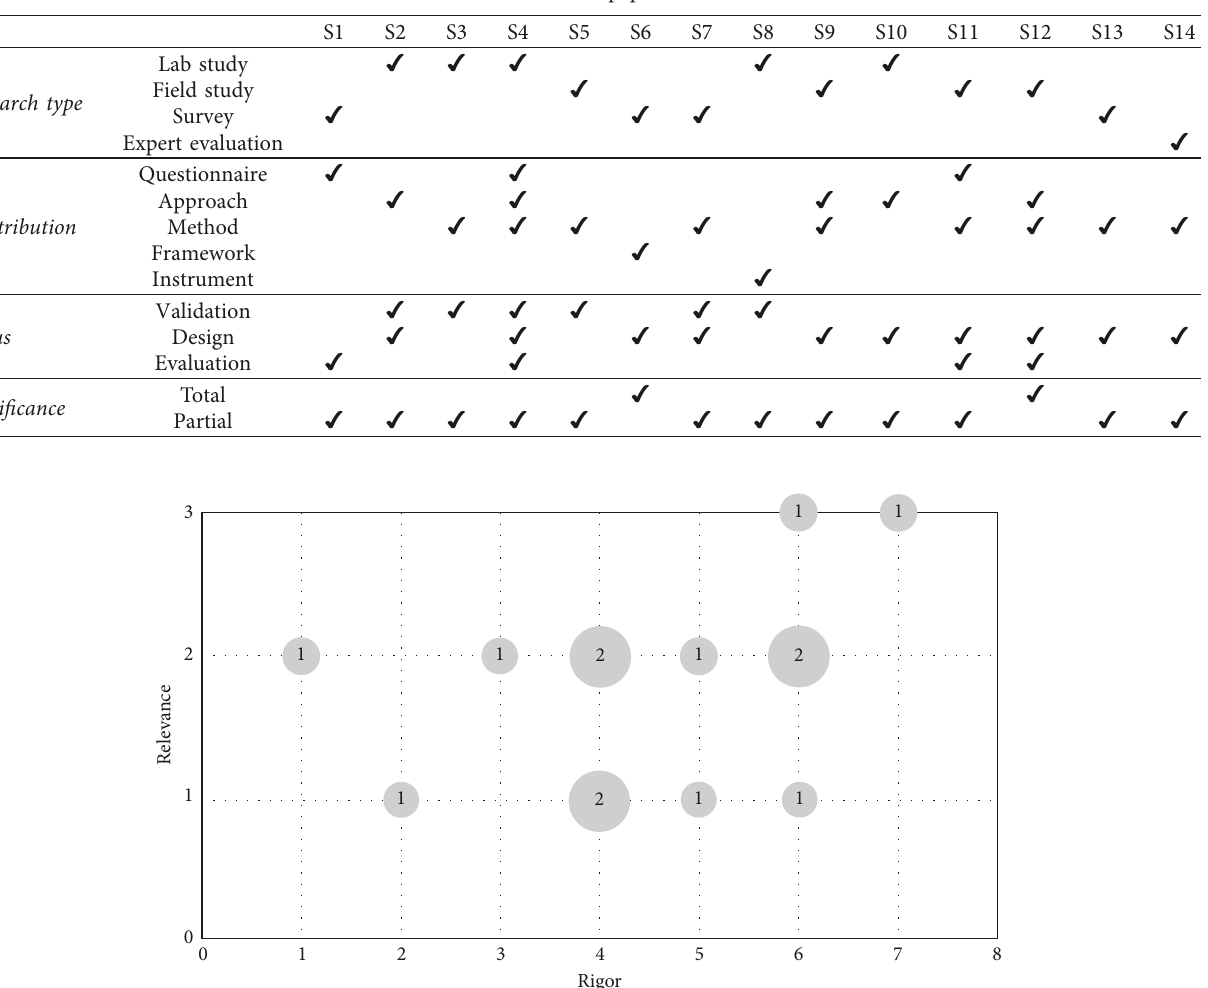
Table 8: Results obtained for the paper classification